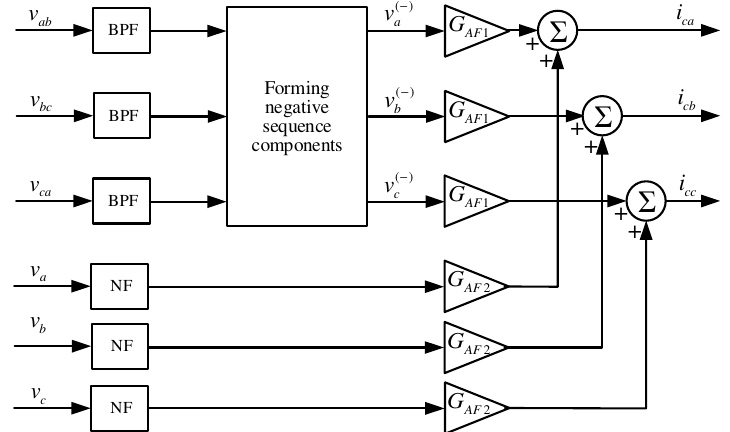
Figure 13. Reference signal computational system for three-phase active